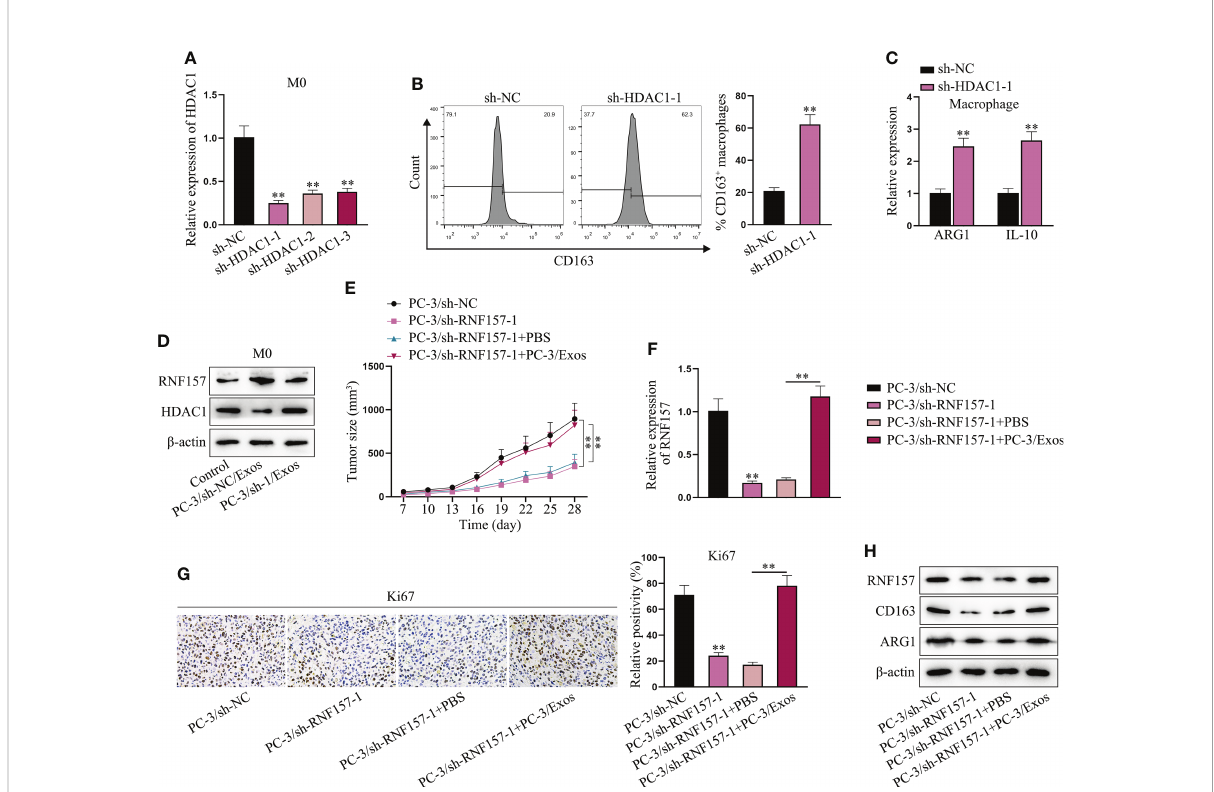
FIGURE 5 Exosomal RNF157 mRNA suppressed HDAC1 expression to induce the M2 polarization of macrophages. (A) RT-qPCR detected the HDAC1 expression in macrophages after transfection of sh-HDAC1-1/2/3. (B, C) Flow cytometry and RT-qPCR analyzed M2 polarization before and after HDAC1 depletion. (D) The protein levels of RNF157 and HDAC1 were analyzed by western blot in macrophages after co-culturing with PC- 3/sh-NC/Exos or PC-3/sh-RNF157-1/Exos. (E) The growth curves of tumors were analyzed. (F) The expression of RNF157 mRNA in tumors was analyzed via RT-qPCR. (G) IHC detected Ki67 level in tumor tissues from different groups. (H) The protein levels of RNF157 and M2 polarization markers (CD163 and ARG1) were analyzed in tumor tissues from different groups. **P <